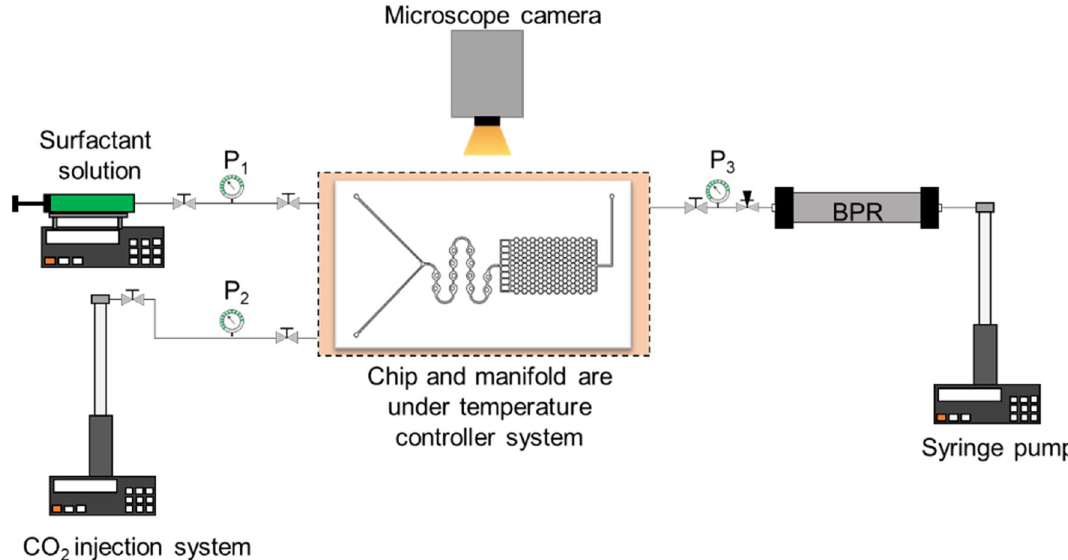
Figure 3. Schematic of the microfluidic setup used to study Sc-CO 2 surfactant foams at a high-temperature high-pressure